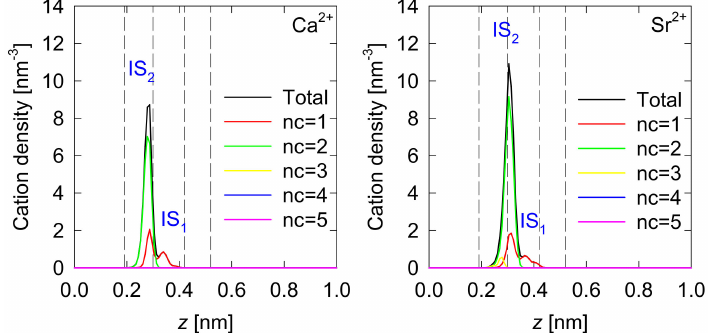
Figure 4. Axial density profiles of alkaline-earth metals close to negatively charged (110) spodumene surface. Surface charge density is − 0.125 C/m 2 . The mean position of peaks from the water density profile is represented by the segmented vertical lines. IS 1 and IS 2 are inner-sphere complexes, respectively, with nc equal one and two contacts between the cation and the spodumene surface. The envelope of the density profile is called